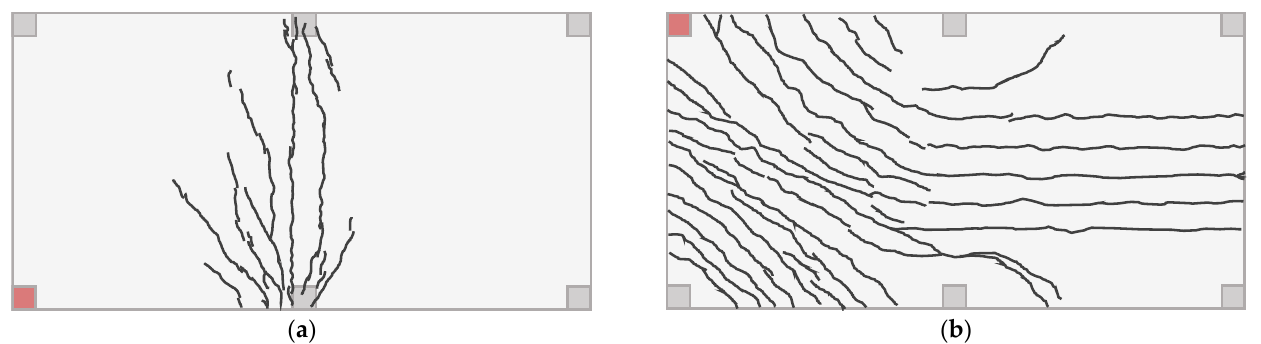
Figure 2. Cracking patterns on the top ( a ) and bottom ( b ) surfaces of the flat slab after corner support loss.